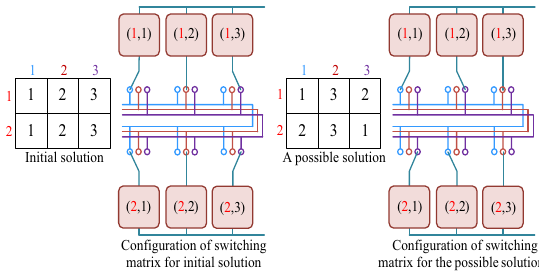
Fig. 3 Coding for solution (2 switching matrix